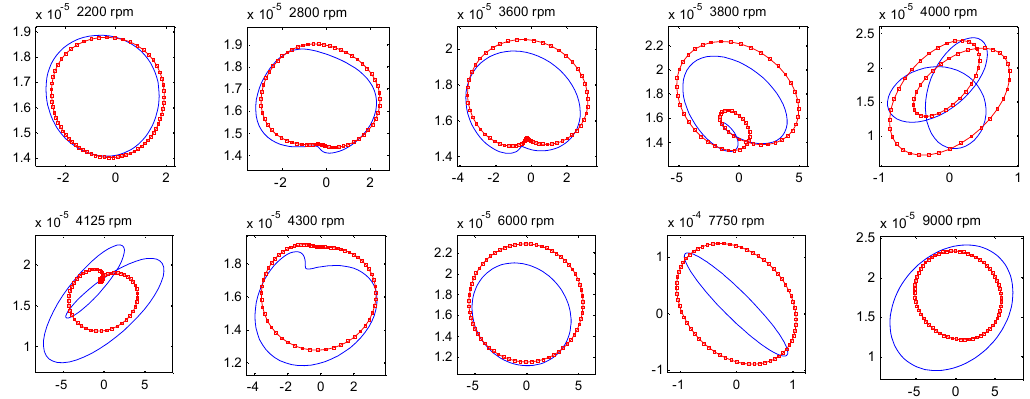
Figure 10. The response amplitudes of the central node of the cracked anisotropic rotor-bearing system with fixed and speed-dependent coefficients: ( a ) along the horizontal direction; ( b ) along the α of both cases equals 1.0, and the parameter vertical direction. The parameter k case is 0.2.